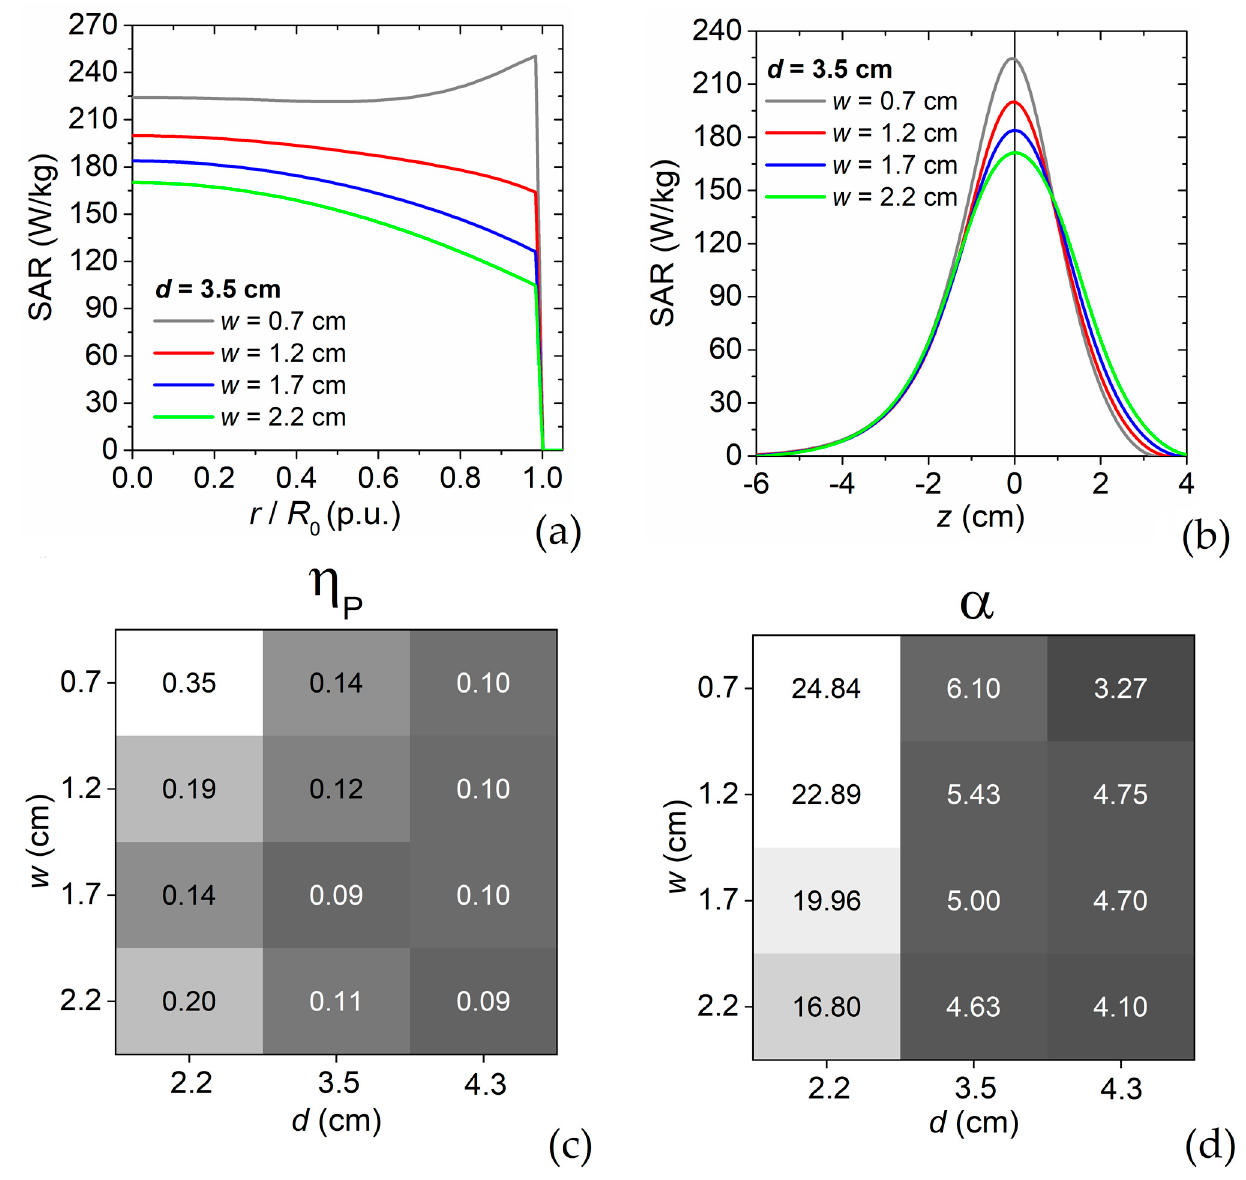
Figure 3. Spatial variation of SAR in the phantom calculated along the ( a ) radial and ( b ) longitudinal axes depicted in the schematic of Figure 1c. The calculations are performed for variable values of the aperture width w , fixing the diameter d of the inner conductor to 3.5 cm. ( c ) Grey-scale maps (light grey corresponds to the highest values) of the ( c ) coefficient of power heterogeneity η P and ( d ) percentage α of power deposited in the VOI, as a function of parameters w and d .